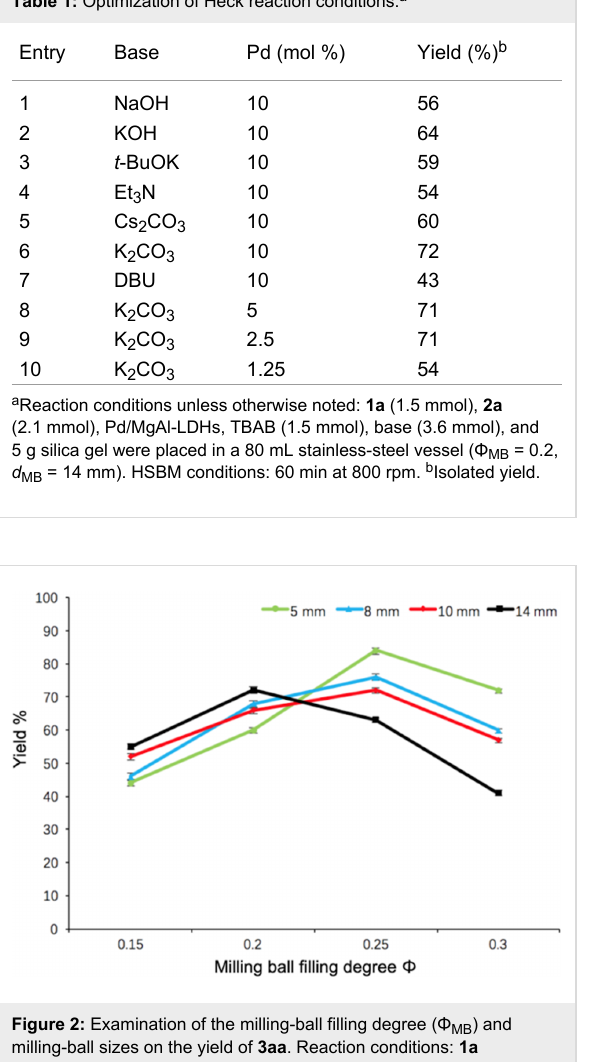
Table 1: Optimization of Heck reaction conditions. a